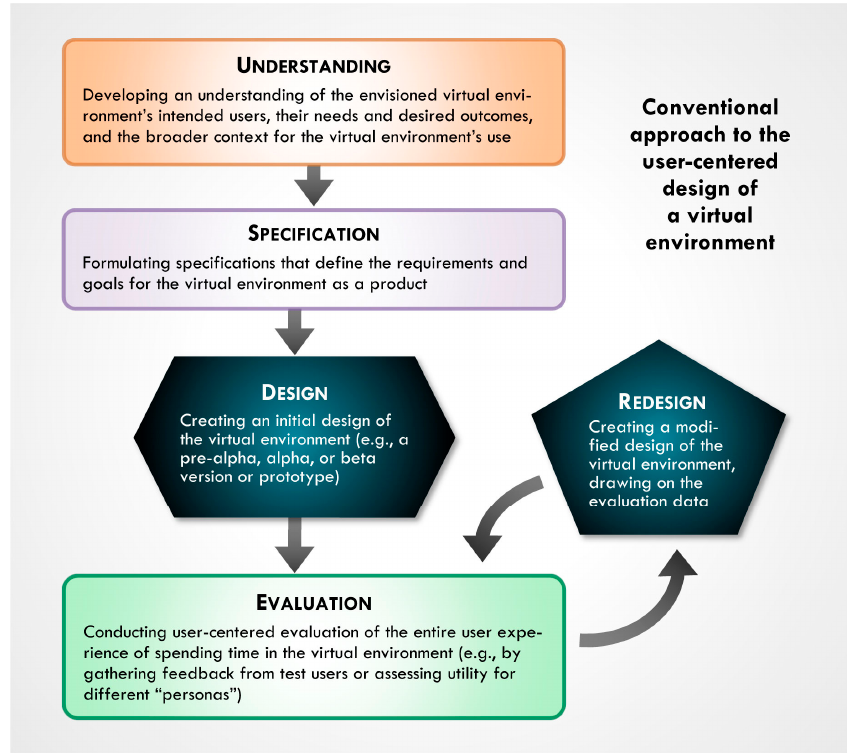
Figure 1. A conventional UCD process applied to the design of a virtual environment. Multimodal Technol. Interact. 2018 , 2 , x FOR PEER REVIEW